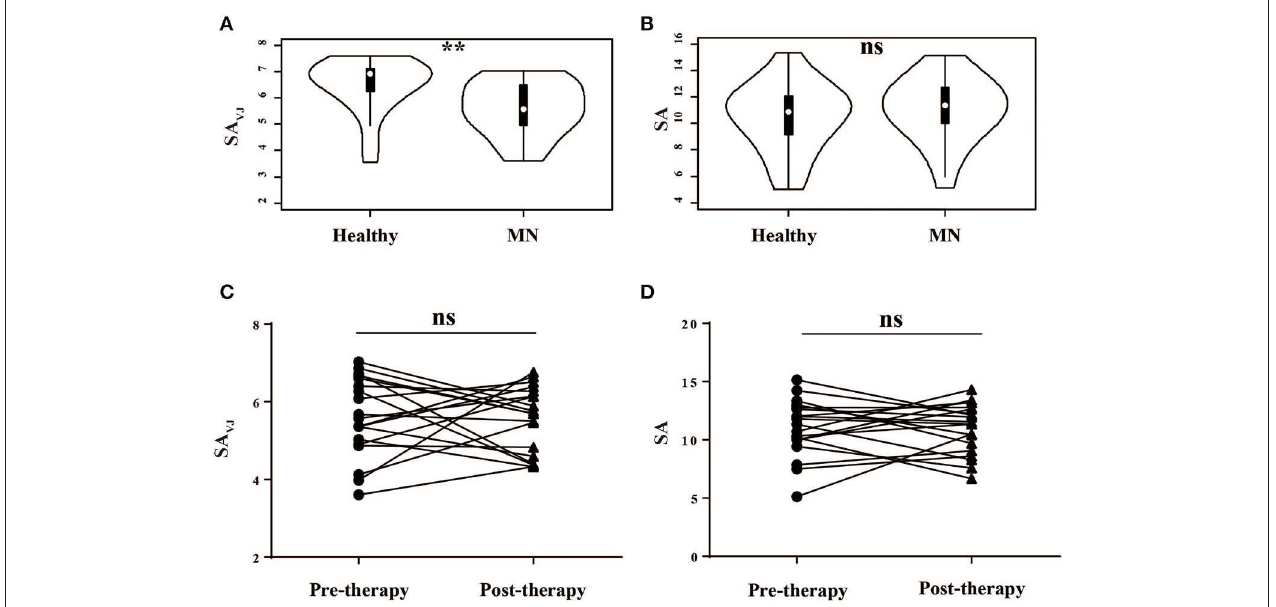
FIGURE 1 | The Shannon’s entropy of peripheral blood TCR repertoire between different groups. The Shannon’s entropy of clonotype (SA) and VJ combination (SA VJ ) between healthy controls and MN patients (A,B) and between pre- and post-therapy (C,D) . ** P < 0.01. ns, no significant.